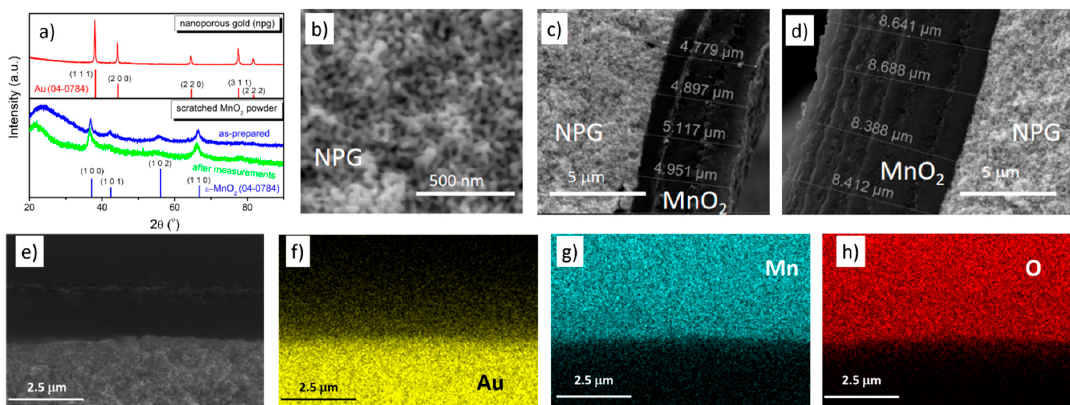
Figure 1. ( a ) The XRD pattern of npg and scratched MnO 2 powder. The SEM images of different